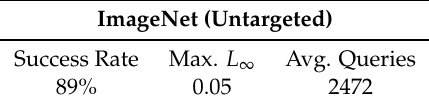
Table 2. Untargeted attack performance for inception-v3 network on ImageNet